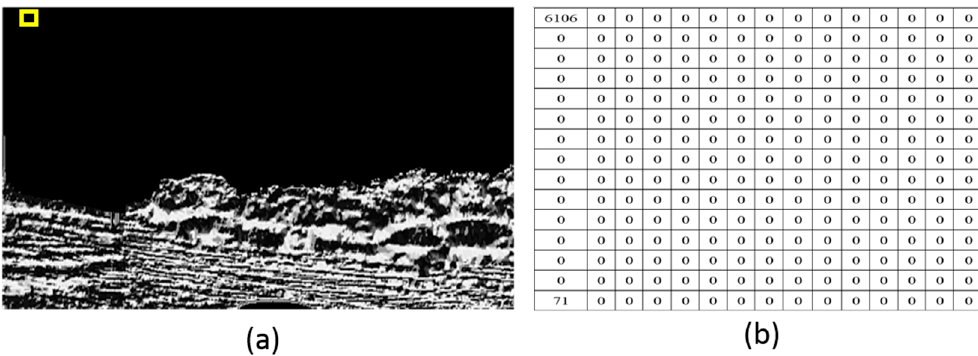
Figure 6. The GLCM when the center pixel is (15, 15). ( a ) The LBP image where the calculation block shown with the yellow rectangle is the calculation position; ( b ) The GLCM result.